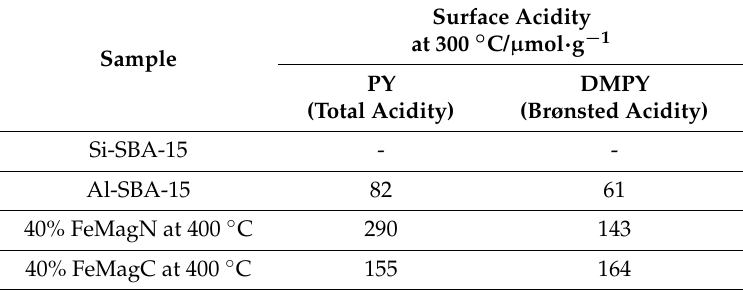
Table 3. Surface acidity measured at 300 ◦ C as µ mol adsorbed of pyridine (PY) or 2,6-dimethylpyridine (DMPY) per gram of sample.